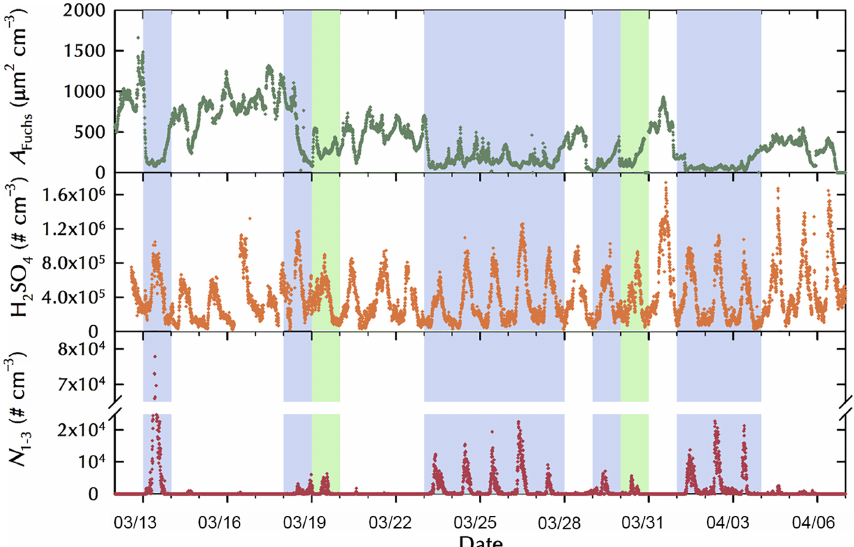
Figure 2. Time series for Fuchs surface area ( A Fuchs ) , the sulfuric acid concentration, and number concentration of 1–3nm particles. Typical NPF days and undefined days are shadowed by light blue and light green background, respectively.